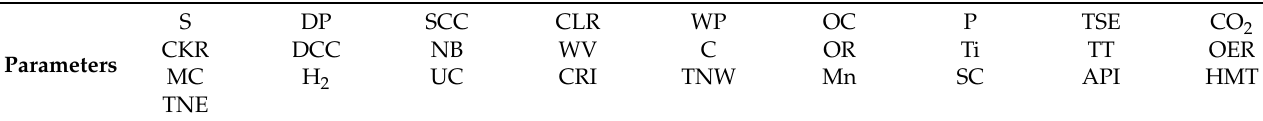
Table 2. Input parameters for the two models.